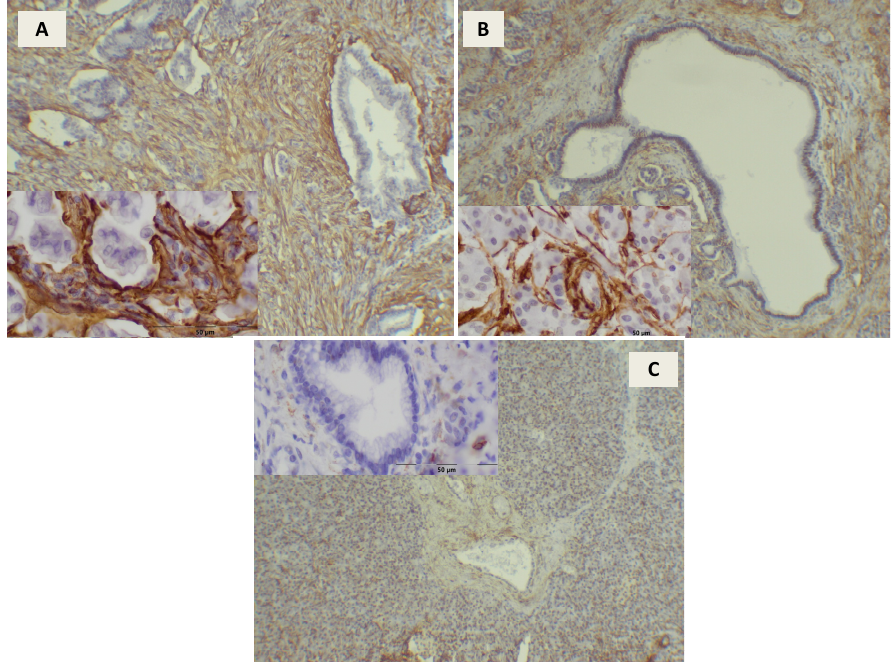
Figure 1. Immunoexpression of α SMA in pancreatic ductal adenocarcinoma - intensity of the reaction 3 ( A ), chronic pancreatitis - intensity of the reaction 2 ( B ) and in the control group - intensity of the reaction 0 ( C ) 100 and 400× magnification.